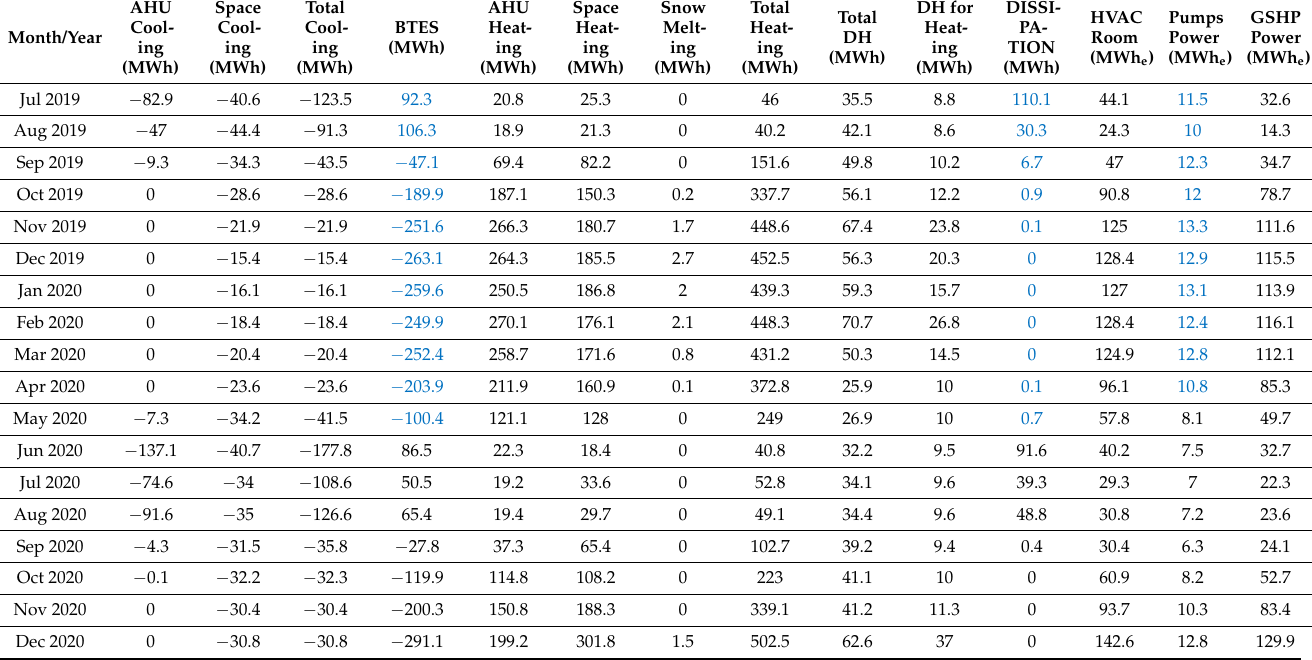
Table 5. Raw measured data and estimations (blue